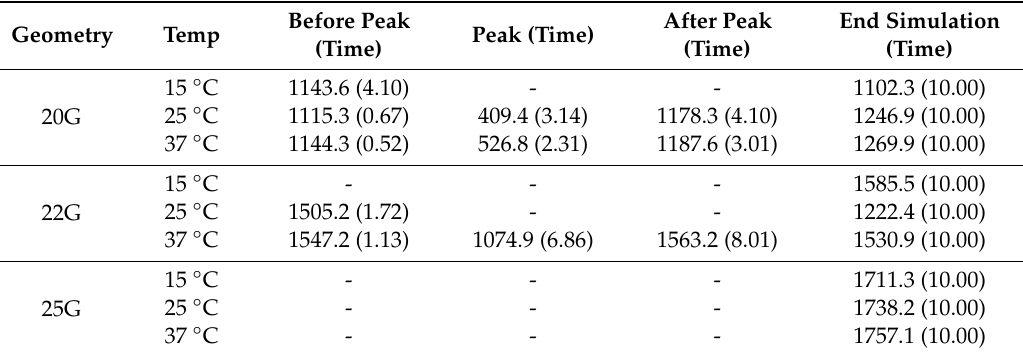
Table 2. Maximum outlet pressure values (Pa) and time